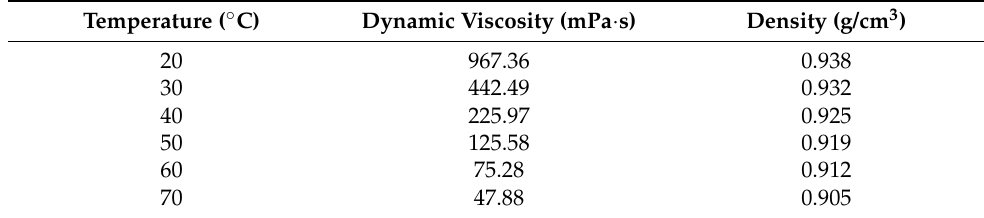
Table 1. Oil properties.